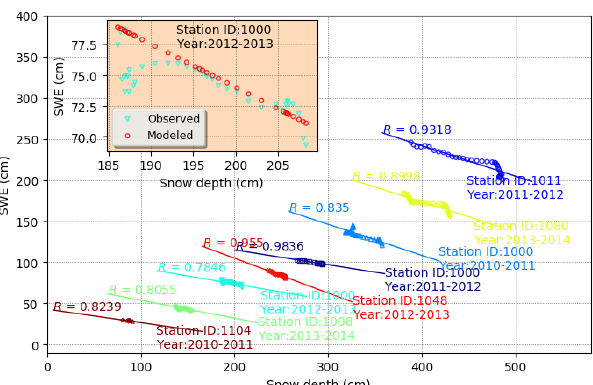
Figure 6. Scatterplot of SWE versus snow depth and the polynomial fitting results in Ptran.